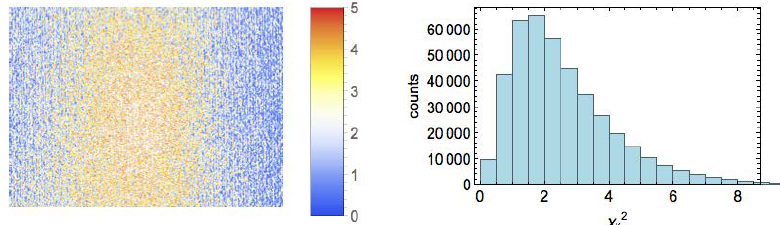
Figure 4. ( left ) Reference image with color map indicating the value of χ 2 ν at each point. ( right ) Frequency distribution of χ 2 ν for the reference